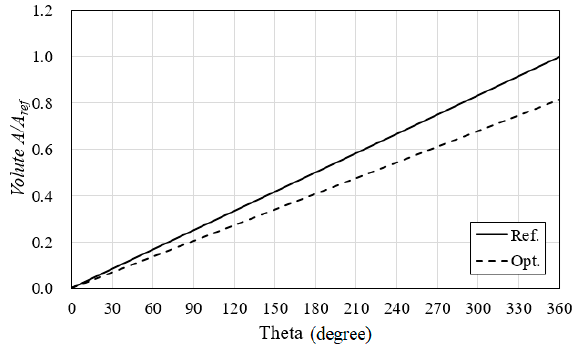
Figure 16. Cross-sectional area distribution of the volute.